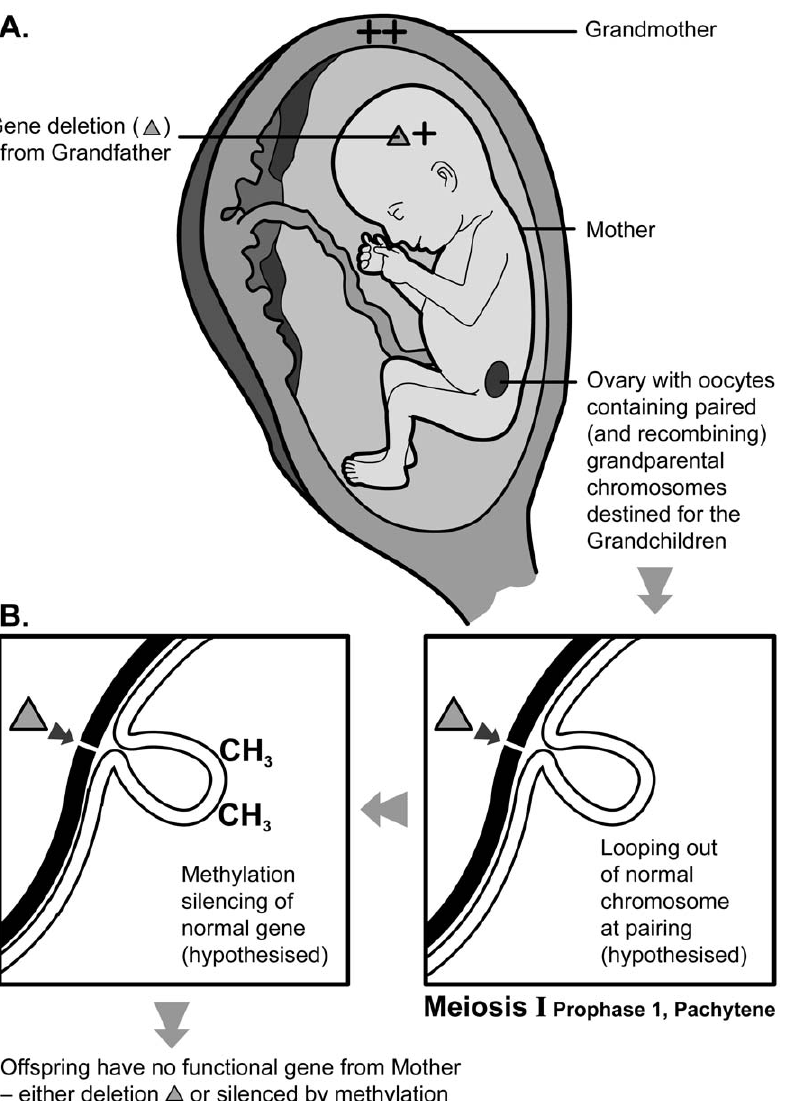
Figure 2. Three generations of genotypes are illustrated (A): that involving the grandmother’s pregnancy, her female fetus and the fetal ovary that contains the emerging genotype of the grandchild. The grandmother has two normal, wild type genes ( ++ ). The fetus has a deletion of the gene inherited from grandfather ( n ) which confers some susceptibility to autistic spectrum disorder. The hypothesised mispairing of the grandparental chromosomes at the site of the gene deletion ( n ) in the fetal oocytes is shown (B). The chromosome containing the wild type gene loops out at meiotic pairing and this gene becomes liable to be silenced by DNA methylation. This results in no grandchild receiving a functional